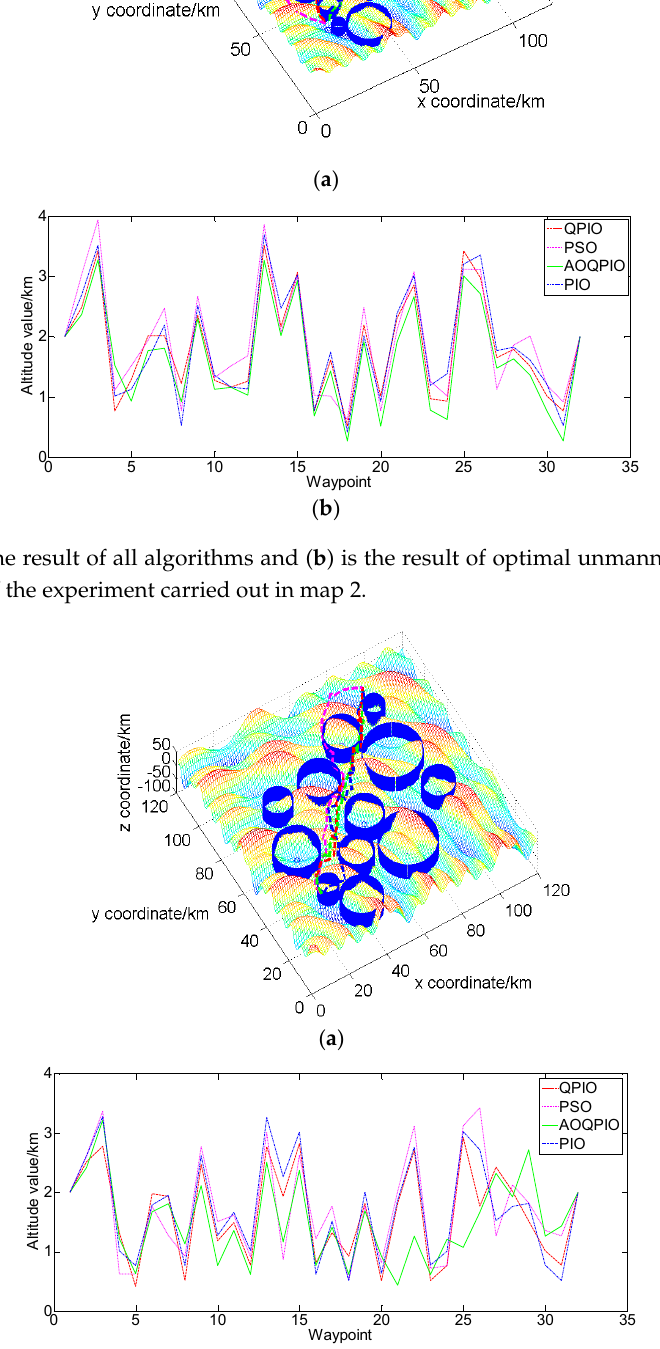
( a ) ( b ) Figure 5. ( a ) is the result of the experiment and ( b ) is the result of optimal UAV altitude of the experiment carried out in map 3.